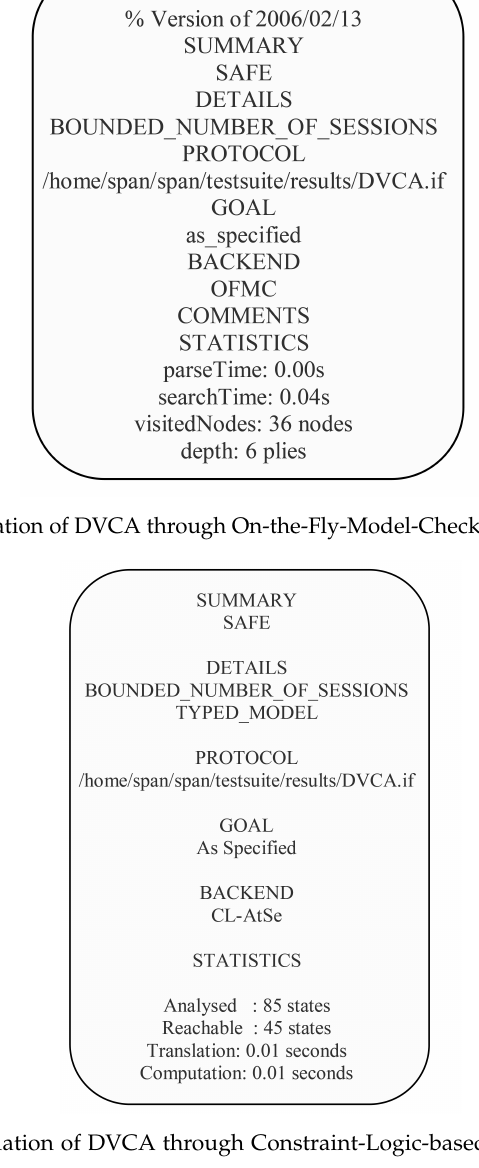
Figure 7. Security validation of DVCA through Constraint-Logic-based Attack Searcher (CL-AtSe) model